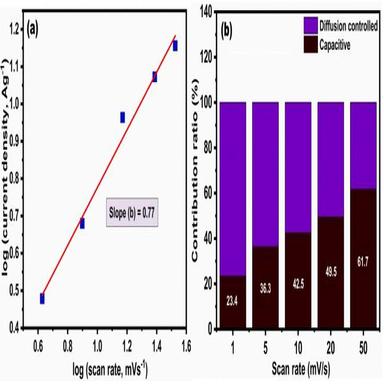
(a) Log (sweep rate) vs log (current density) plot and (b) contribution ratio (%) of the diffusion control and surface control at different sweep rates of (In2O3)0.3/(Fe2O3)0.7 electrode.